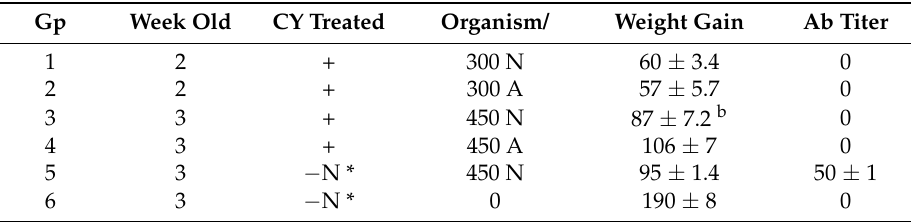
Table 1. Effects of low doses of aberrant and normal organisms in juvenile immunodeficient or immune-intact Rhode Island Red animals.